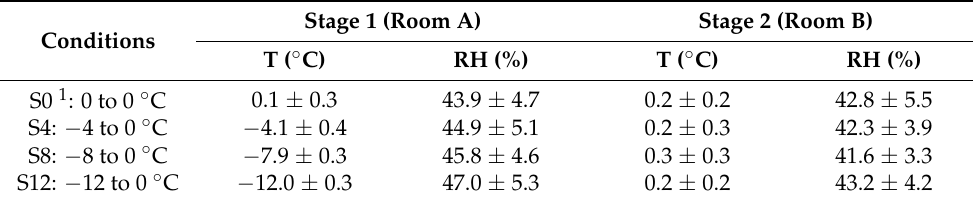
Table 3. Experimental